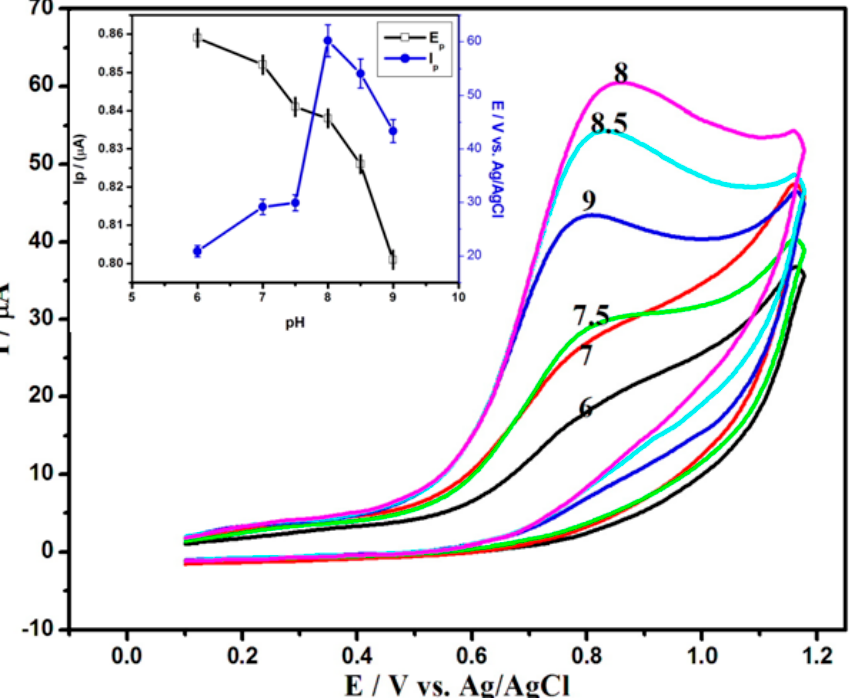
Figure 8. CVs of 3.5 mM of NIC in 0.1 M of Na 2 SO 4 of various pH values: (6.0, 7.0, 7.5, 8.0, 8.5, and 9.0) at the GO/Nq/GCE with a scan rate of 100 mV/s. (inset Figure 8) A relation between pH versus both oxidation peak potential and oxidation peak current of NIC